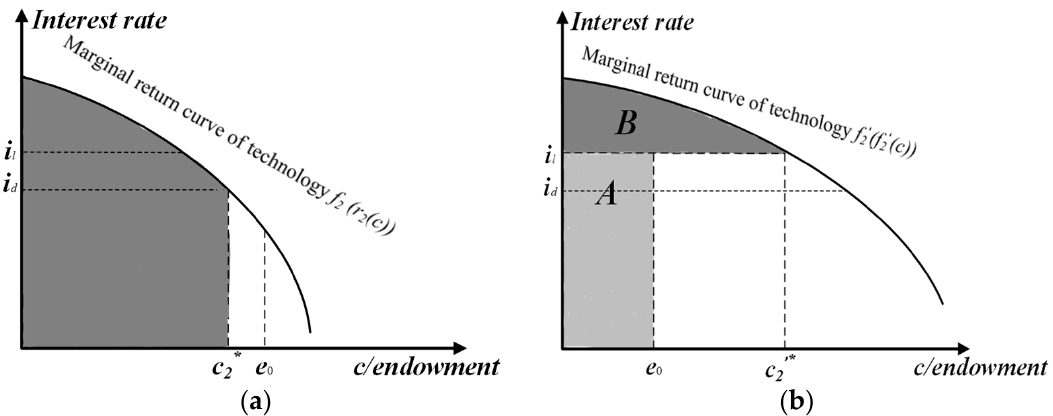
Figure 2. Changes of farmers’ adoption income with technology adoption cost: ( a ) Income of low-cost technology adoption; ( b ) Income of high-cost technology adoption. The shaded part A represents the income affected by farmers’ endowment ( 𝑒 (cid:2868) ), while the shaded part B represents the constant income. 𝑐 (cid:2870)∗ and 𝑐 (cid:2870)∗(cid:4593) are the corresponding optimal investment.